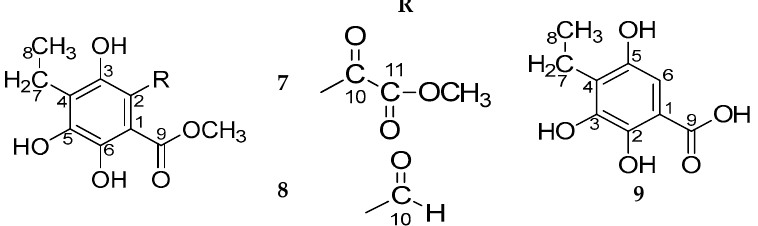
Figure 7. Structures of dimethyl ether of compound 7 , methyl ether of compound 8 , and of compound 9 . Table 3. NMR data of dimethyl ether of compound 7 (500 MHz for 1 H and 126 MHz for 13 C, δ , ppm, J /Hz), methyl ether of compound 8 , and of compound 9 (700 1 H and 176 MHz for 13 C, δ , ppm, J /Hz).